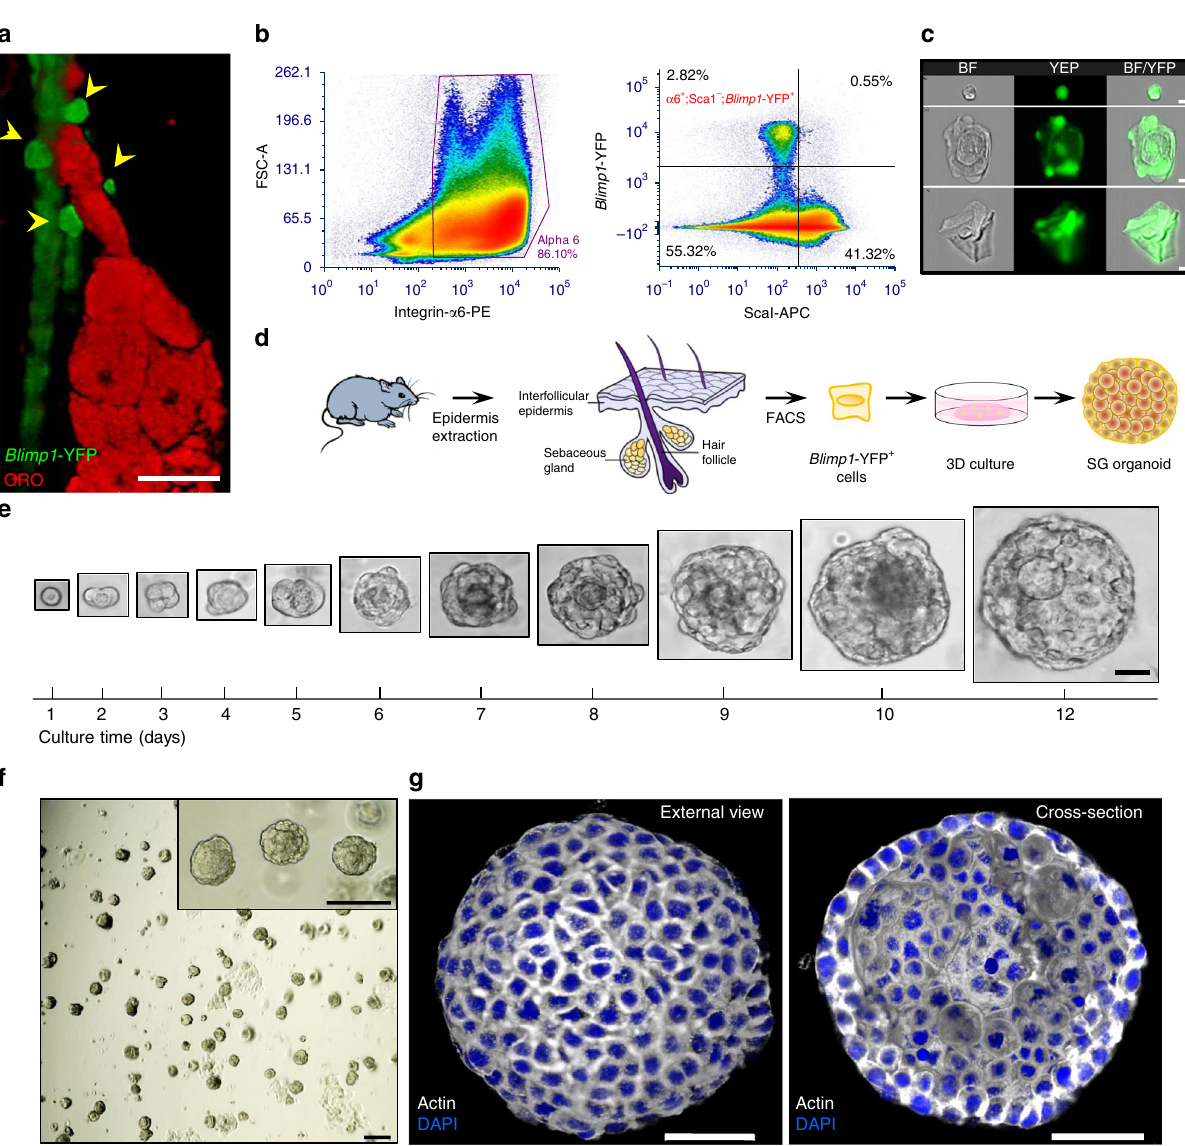
Fig. 1 Single Blimp1 + cells generate sebaceous gland-like structures ex vivo. a Representative image of dorsal skin wholemount extracted from P56 (telogenic)-old B6.Cg-Tg(Prdm1-EYFP)1Mnz/J (denoted Blimp1-YFP ) mouse stained for Oil Red O (ORO). Blimp1 -YFP + signal (yellow arrows) can be seen at the base of the sebaceous gland (SG) [ n = 5 mice]. b Fluorescent-activated cell sorting (FACS) analysis employing Blimp1-YFP reporter mice demonstrating the α 6 + ;Sca1 - ; Blimp1 - YFP + ( Blimp1 -YFP + ) population [ n = 5 pooled mice]. c Image stream analysis showing representative bright fi eld (BF) images of Blimp1 -YFP + cells, indicating that these cells display three distinct morphologies: (1) small cells with high circularity, (2) large cells resembling sebocytes, and (3) differentiated keratinocytes. d Schematic diagram representing the process of Blimp1 -YFP + cell-derived organoid generation. e Representative images of initial single seeded Blimp1 -YFP + cell maintained in 3D culture for a period of 12 days. Scale bar is relative to all images shown for each day. f Single-cell suspension of Blimp1 -YFP + cells, supplemented with growth factors, form a large number of organoids after a period of 1 week. g Representative 3D-reconstructed confocal image of an organoid after 10 days in culture stained for actin. Left panel shows an external view of a layer of compact similarly sized cells, while the right panel demonstrates cross-section of large inner cells of varying sizes. All experiments were repeated at least three times with similar results. Organoids were grown from a mix of at least three mice and cultured in three independent biological repeats. Scale bars: 10 μ m ( c ), 20 μ m ( a, e ), 50 μ m ( g ), 100 μ m ( f, f